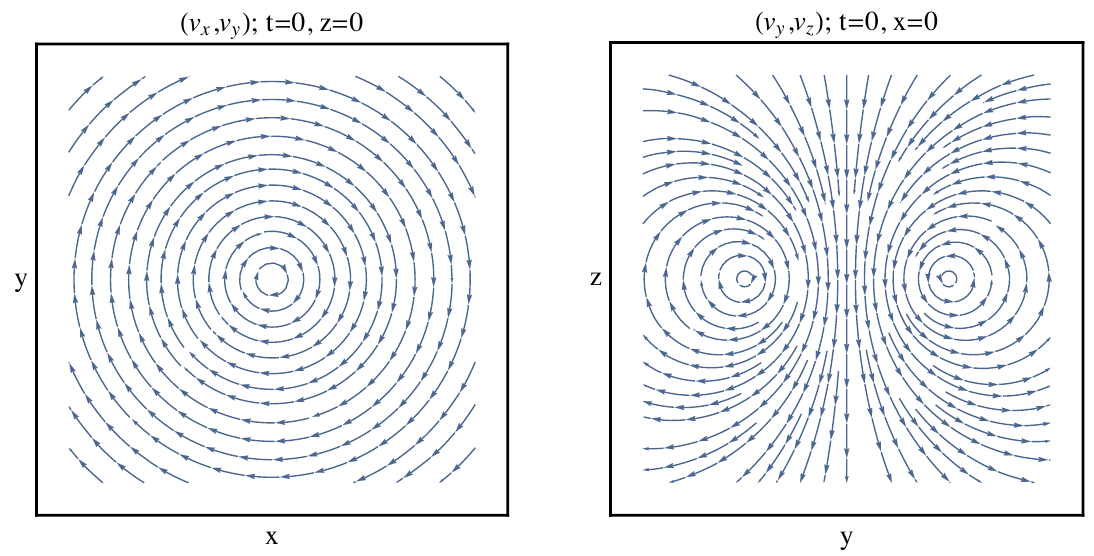
Figure 1 . Orthogonal sections of the velocity field for the Hopfion solution, on the ( x, y ) plane (top) and ( y, z ) plane (bottom). Using rotational symmetry in the ( x, y ) directions the linked torus structure is apparent [12, 13].